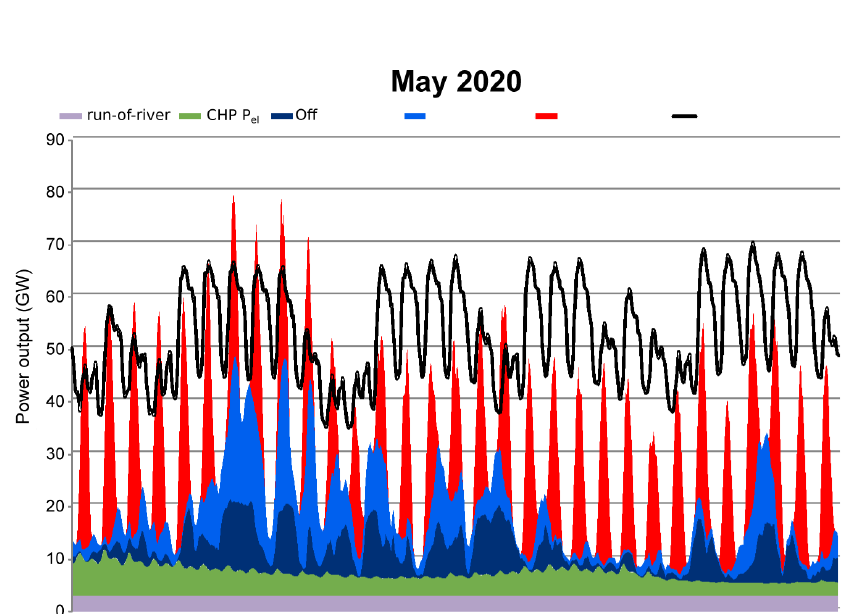
Fig. 8. – The projected electrical power demand and corresponding generation from intermittent as well as non-dispatchable sources during May 2020